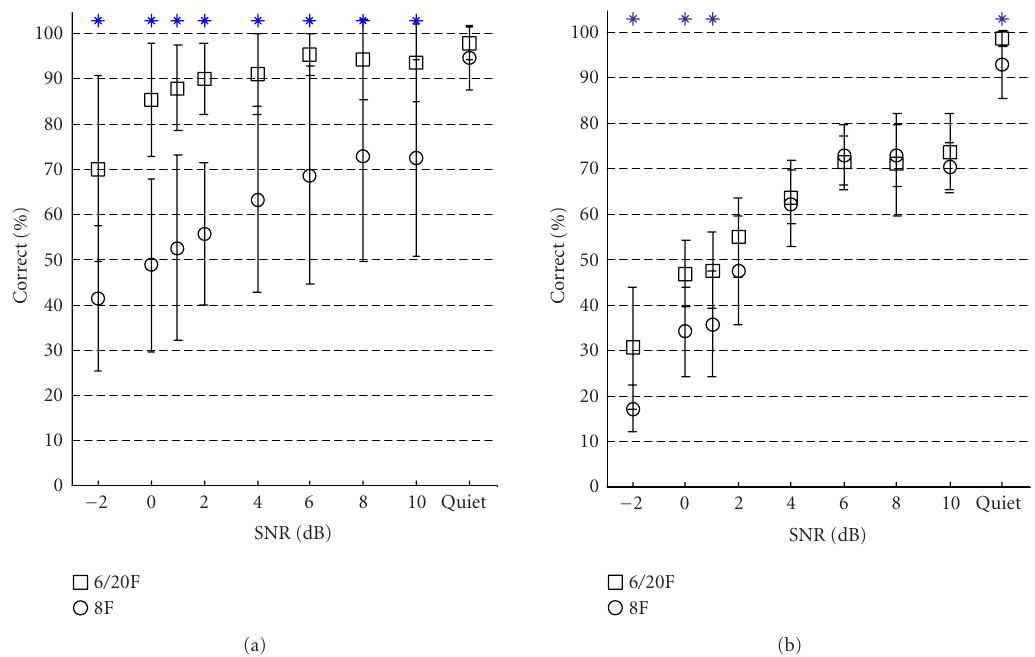
Figure 2: (a) Vowel token recognition scores. (b) Consonant token recognition